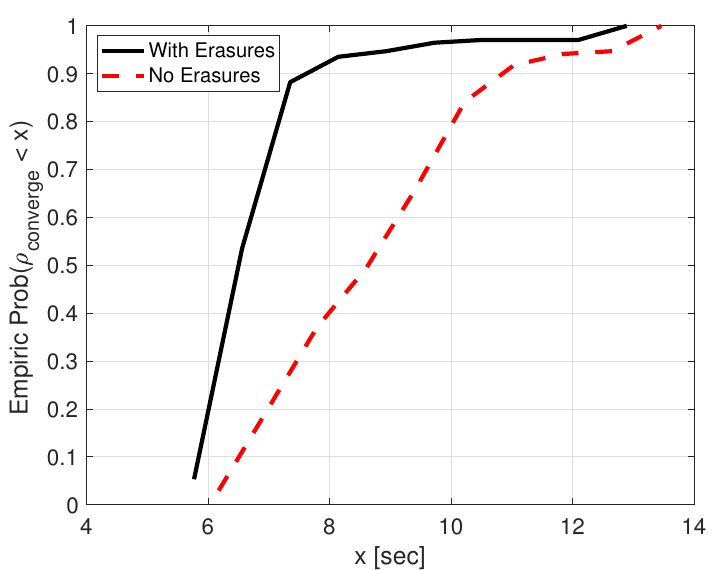
Figure 3. Empirical CDF of convergence time ρ converge . The average result is 8.5 s and 10.4 s for using and not using erasure information, respectively.